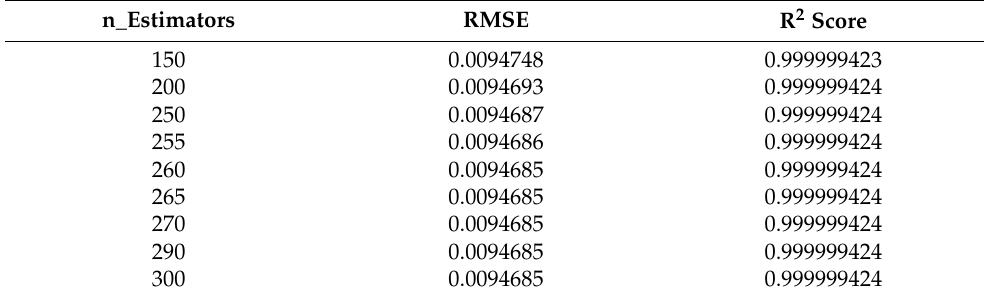
Table 1. n_estimators adjusted errors and